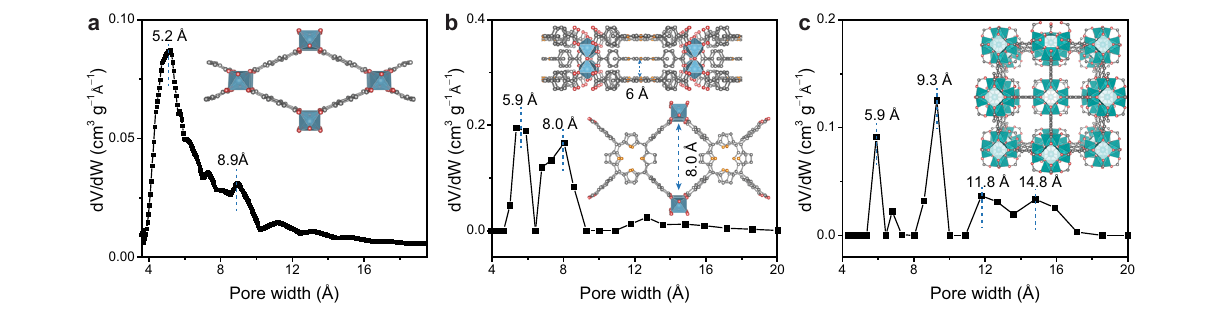
Fig.2|PoresizedistributionsofMOFchannels.a The1DMIL-53(MP)channelsof~5.2×8.9Åindiameter. b TheAl-TCPPchannelcomposedof~8Å1Dchannelsand~6Å 2D interlayer spaces. c The 3D porous UiO-66 channel composed of ~12Å octahedral cavities, ~9Å tetrahedral cavities, and ~6Å triangular windows.